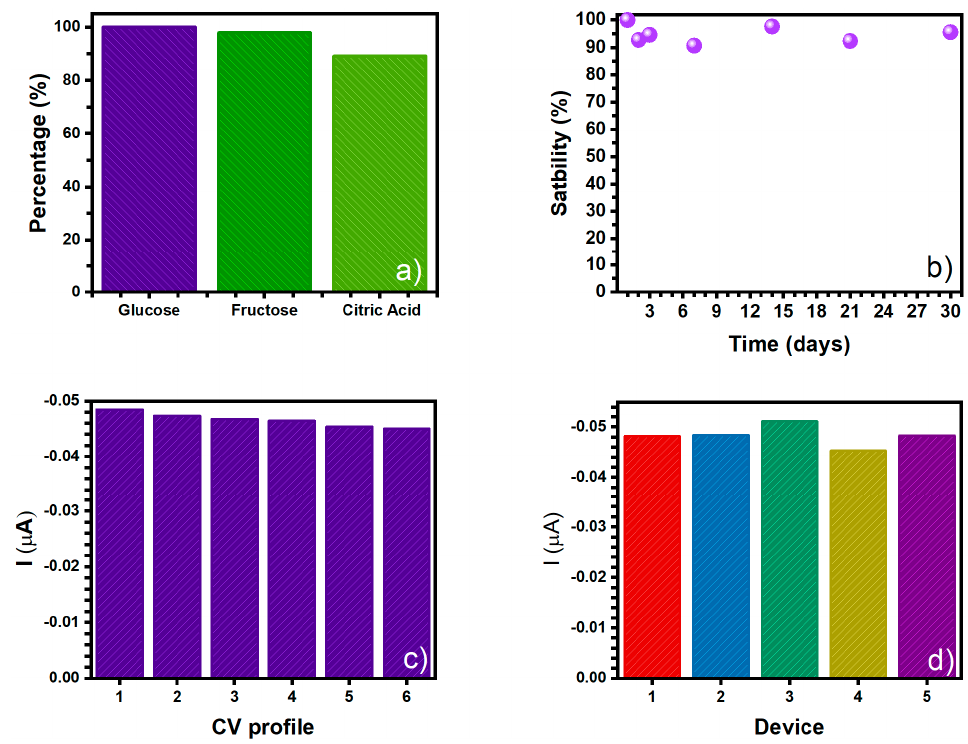
Figure 14. ( a ) Effects of the presence of food additives fructose and citric acid on the CV measurement for 7 mM of glucose in CNT-SPE/A/AuNPs, ( b ) electrochemical response stability of the CNT-SPE